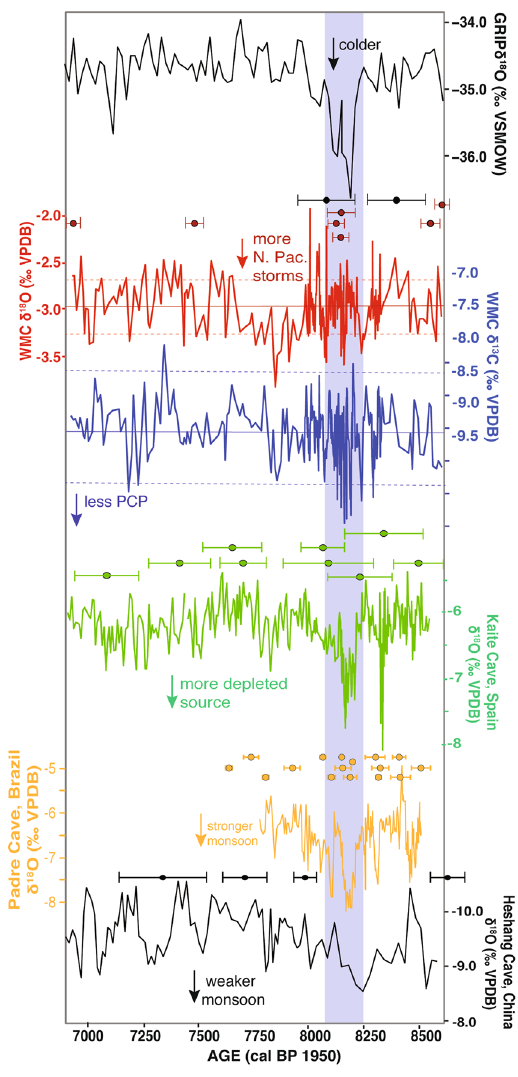
Figure 2. Select global proxy records of the 8.2 ka event compared to the WMC record. From top to bottom: GRIP ice core δ 18 O 56 ; speleothem, δ 18 O (red), and δ 13 C (blue) from WMC (this study); and speleothem δ 18 O from Kaite Cave, Spain 41 , Padre Cave, Brazil 8 , and Heshang Cave, China 57 . Associated U-series ages and 2 σ errors shown by circles and error bars above each speleothem record. For WMC, ages shown in black required large, model-dependent corrections for initial Th and are not used in the age model; date for highly detritus-rich sample AC-2 is not shown. The timing and duration of the 8.2 ka event based on the GRIP record is shown by the blue shaded bar. Dashed horizontal black lines delineate WMC records from this study. Solid and dashed red and blue lines for the WMC stable isotope proxies designate the mean values for the entire record and the 1SD (oxygen) and 2SD (carbon) ranges,